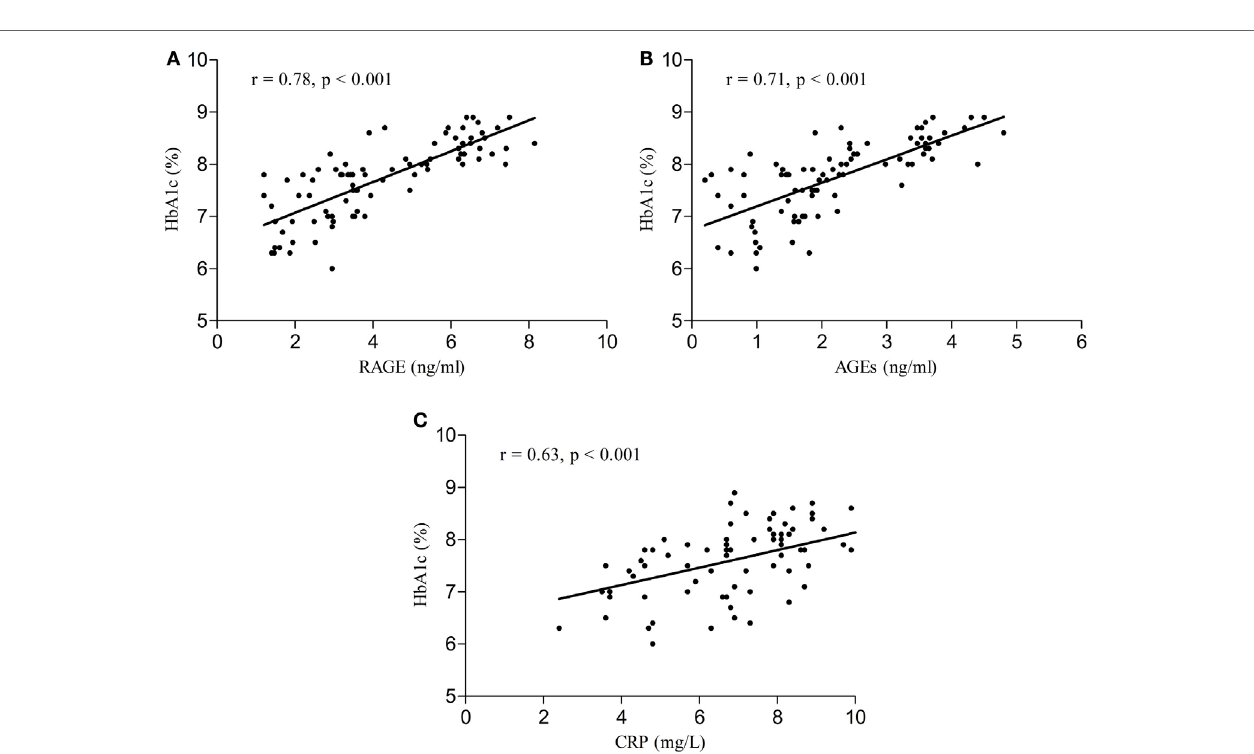
FigUre 2 | (a) Correlation of HbA1c with RAGE in group of diabetic elderly patients with MCI. (B) Correlation of HbA1c with AGEs in group of diabetic elderly patients with MCI. (c) Correlation of HbA1c with CRP in group of diabetic elderly patients with MCI.